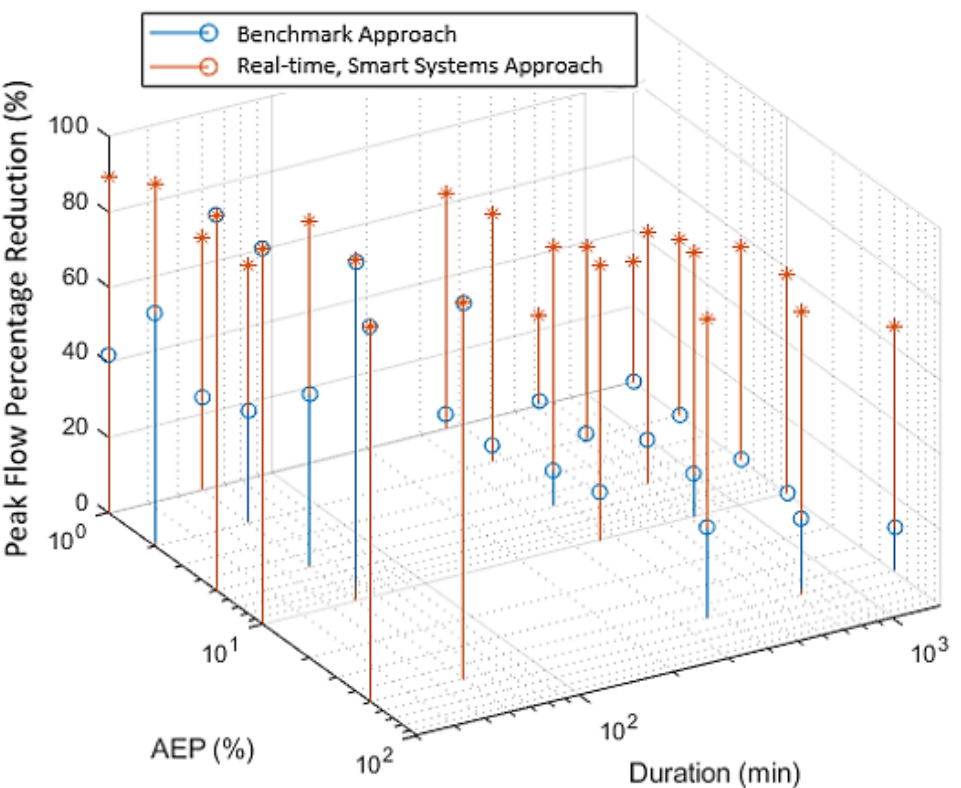
Figure A6. Percentage peak flow reduction of benchmark tanks and real-time, smart tank systems for a range of durations and AEPs with 2 × 10 m 3 tanks in Sydney.